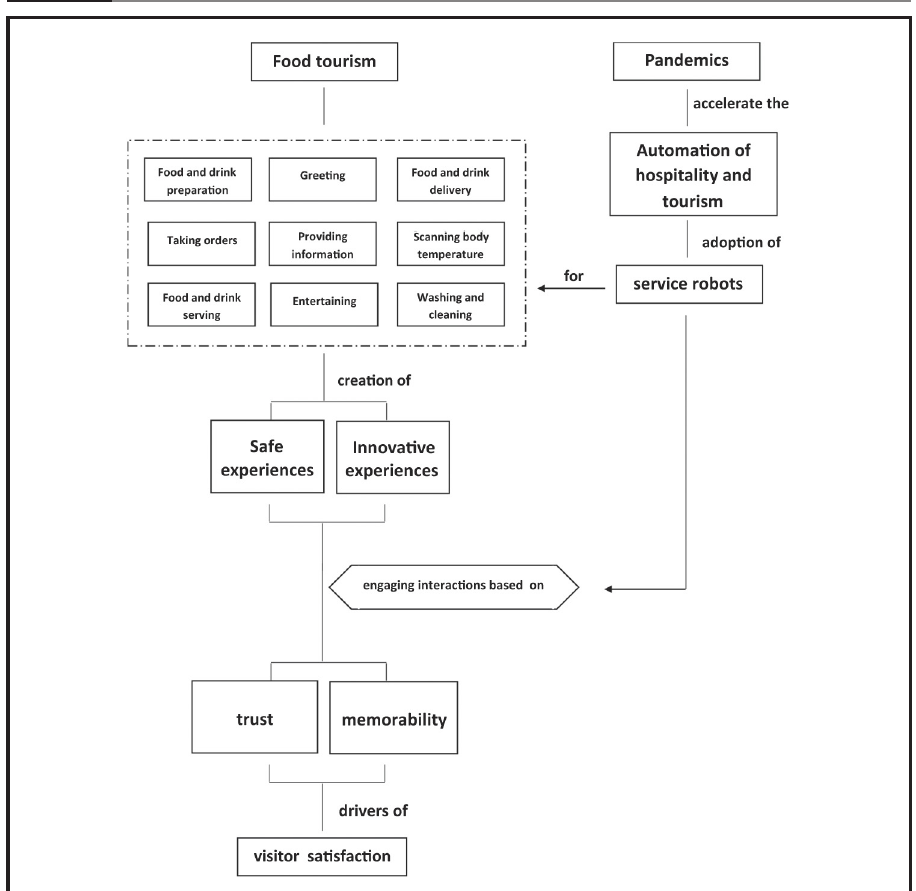
Figure 1 Robots as providers in service experiences in food tourism crisis